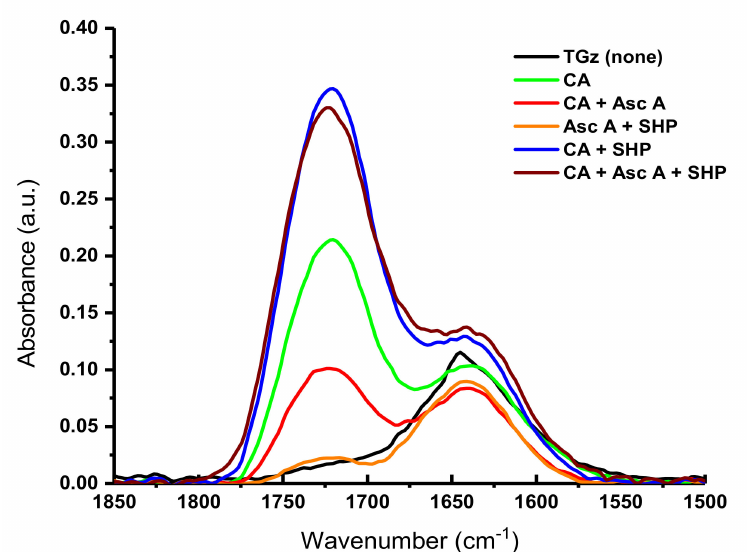
Figure 6. Fourier transform infrared spectra (1850–1500 cm − 1 ) of crosslinked TACGauze (TGz); black line shows no treatment; other lines show treatment with 9% citric acid (CA), 5% ascorbic acid (Asc A), and 3% sodium hypophosphite (SHP) with their various control combinations.